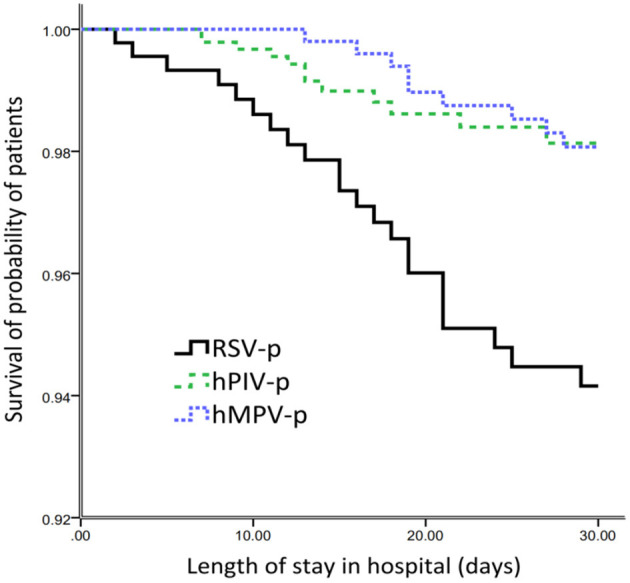
Survival rate of patients hospitalized with the three types of PMVs-p (censored at 30d after admission).